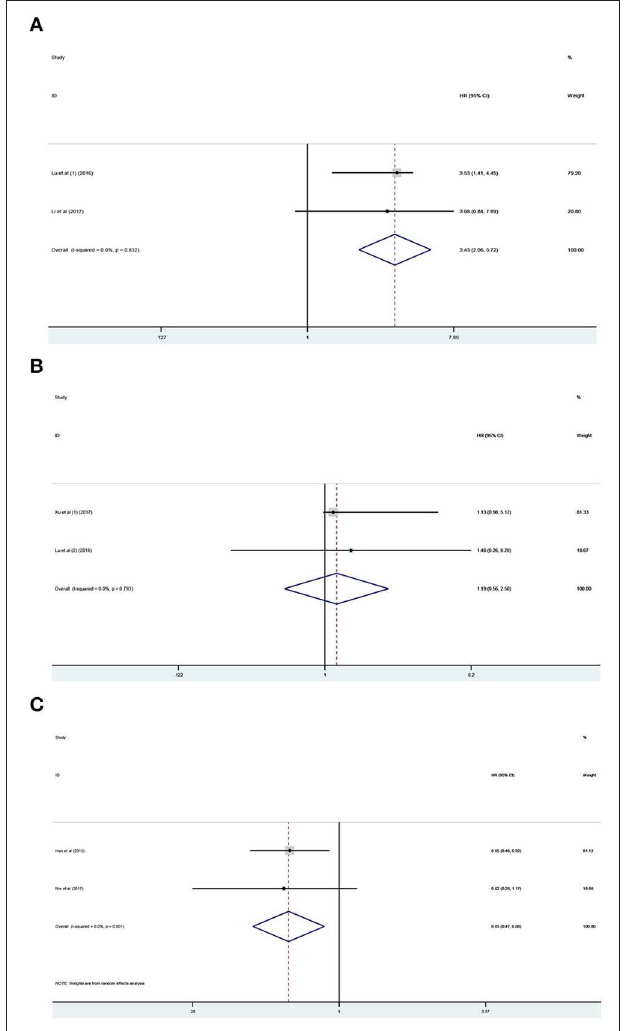
FIGURE 5 | Meta-analysis of the pooled HR of OS for colorectal cancer (A) , renal cell carcinoma (B) , and non-small cell lung cancer (C) .